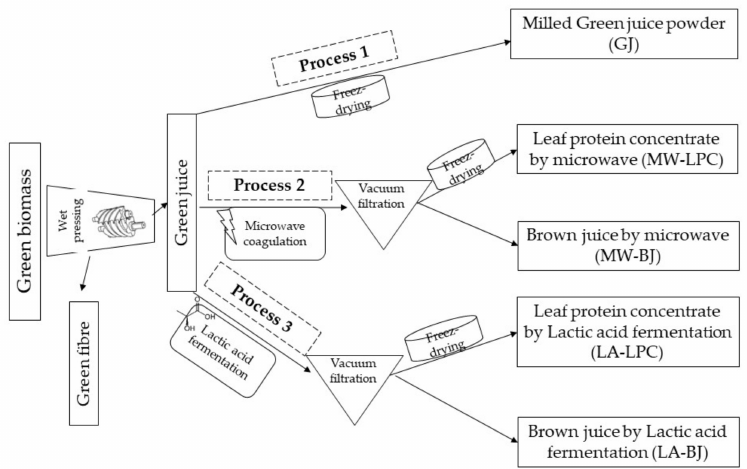
Figure 1. Schematic chart flow of the three applied protein extraction processes of broccoli green biomass, including the obtained product